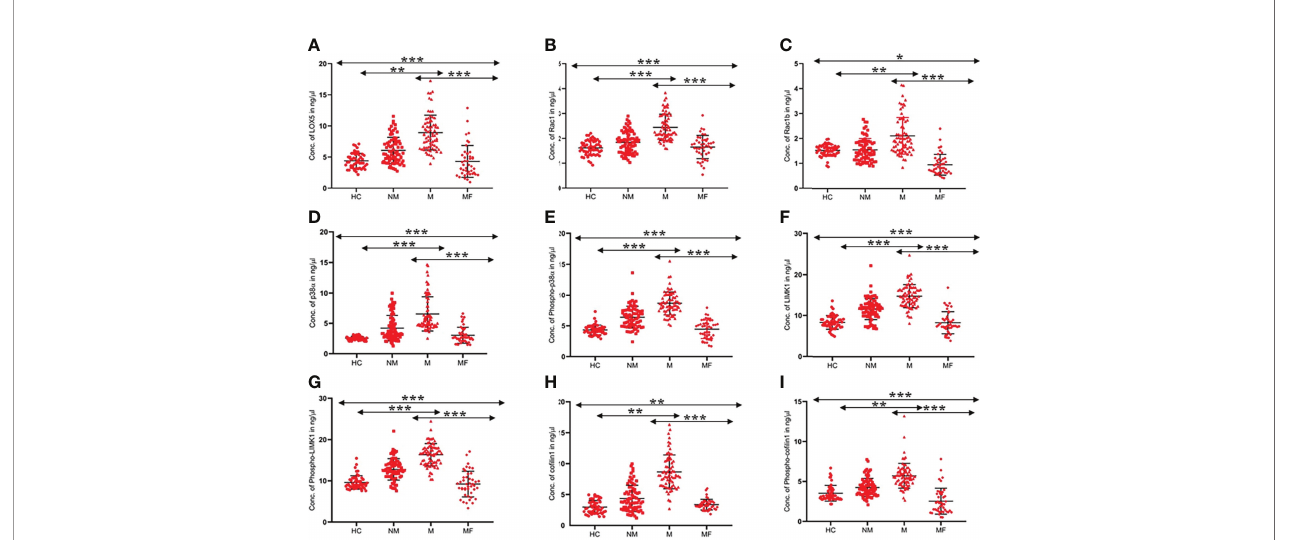
FIGURE 1 | Scatter graph illustrated level of proteins (A) . LOX5, (B) . Rac1, (C) . Rac1b, (D) . p38a, (E) . Phospho-p38a (F) LIMK1 (G) Phospho-LIMK1 (H) Co fi lin1 (I) Phospho-Co fi lin1 in the serum of HC, NM, M, and MF (MF-metastatic post-therapy follow-up). For each group, standard error of the mean (mean ± SE) was plotted. ANOVA test was used to compare the means between the groups *- p <0.01, **- p <0.001, ***- p